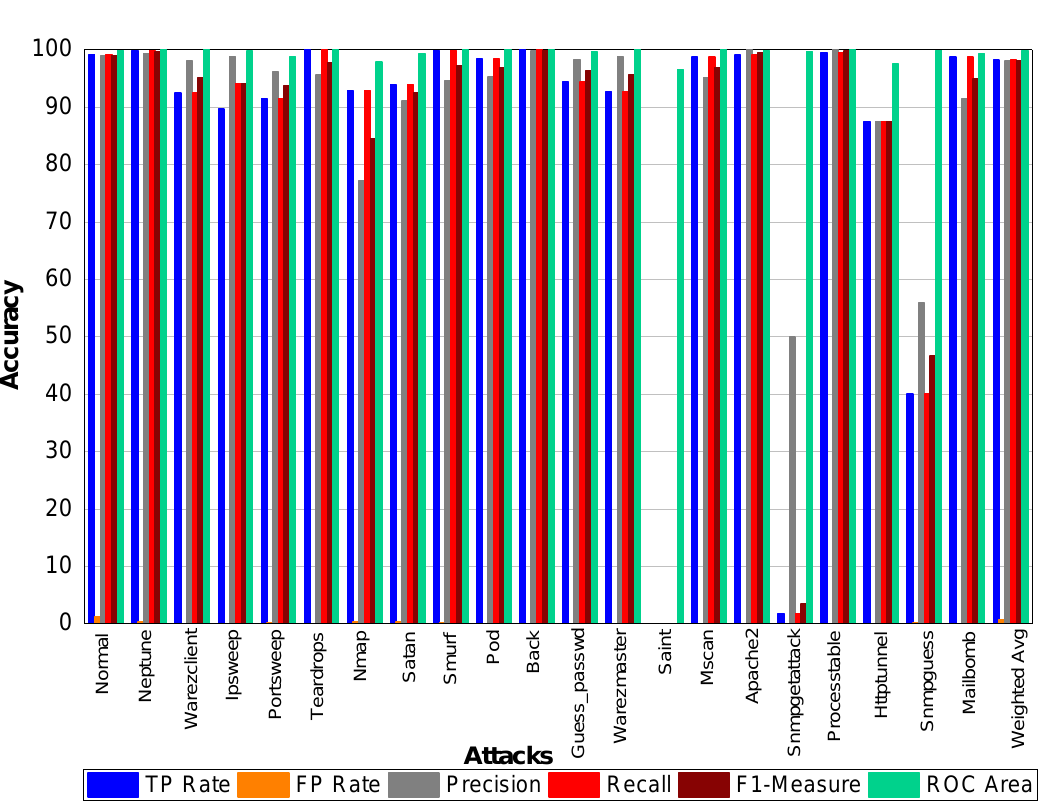
Figure 14. Classification report for the Reptree NSLKDD